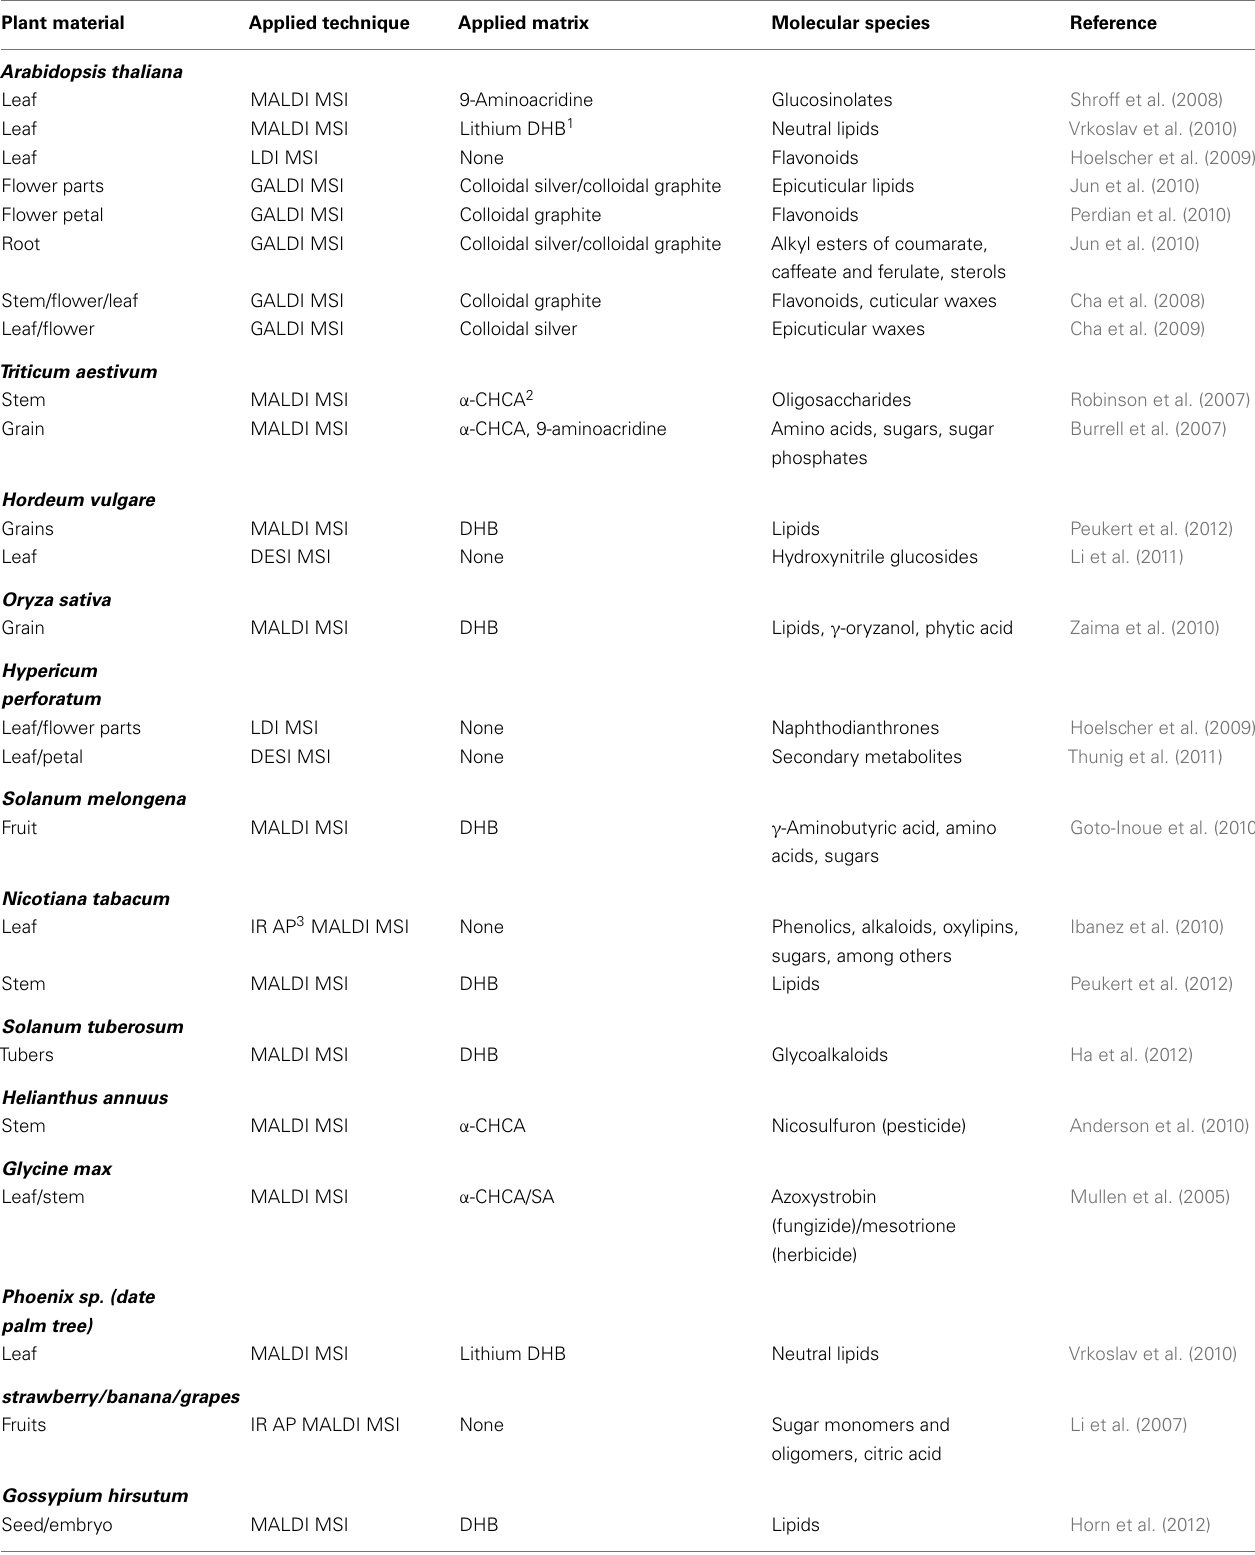
Table 1 | Published literature describing the application of MS imaging for the analysis of small molecules from plant